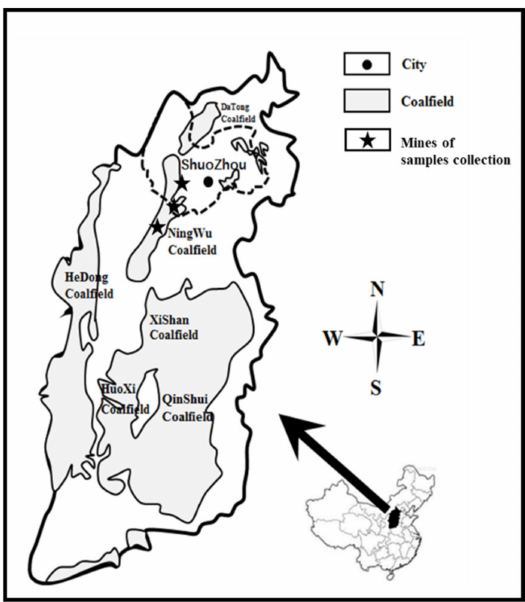
Figure 1. Locations of samples from Ningwu Coalfield, Shanxi, China.